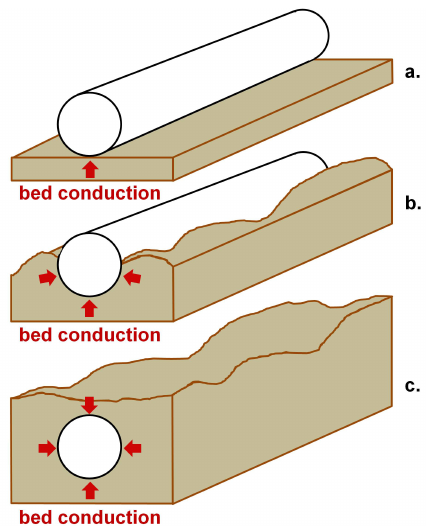
Figure 1. The impact of bed conduction on DTS measurements de- pends on the degree of fiber optic cable burial within bed materials, including (a) not buried, (b) partially buried, and (c) fully